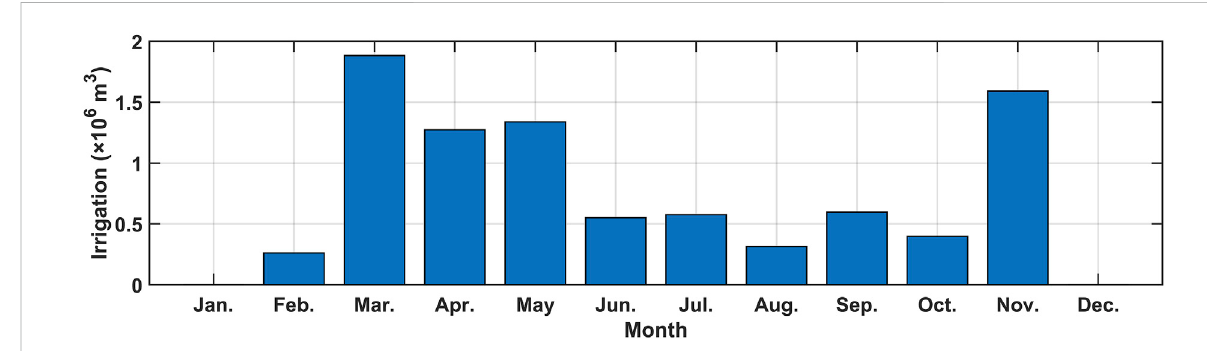
Monthly irrigation volumes in Heifangtai, data are retrieved from Xu et al.